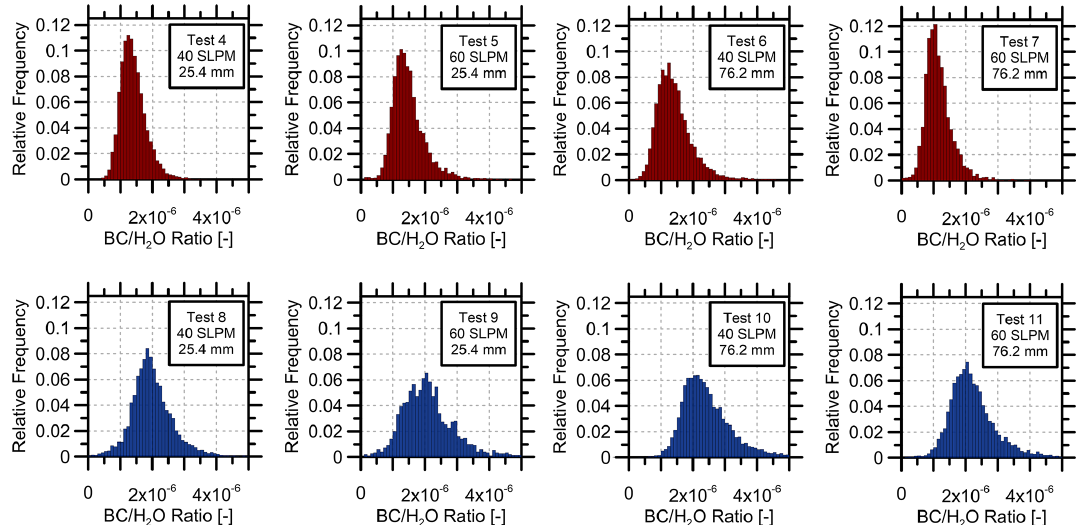
Figure 7. Black carbon (BC) / H 2 O volume fraction ratios for tests with the Bakken flare gas mixture (top row) and Ecuador flare gas mixture (bottom row).